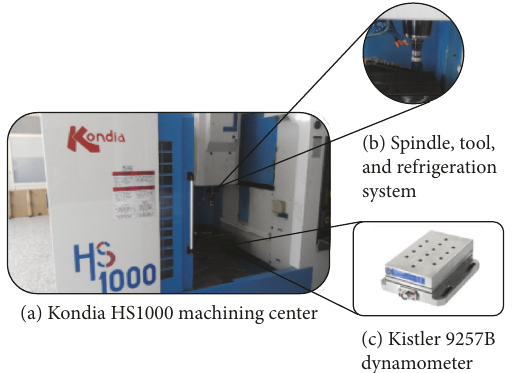
Figure 4: Kondia HS1000 machining center and sensoring equip-